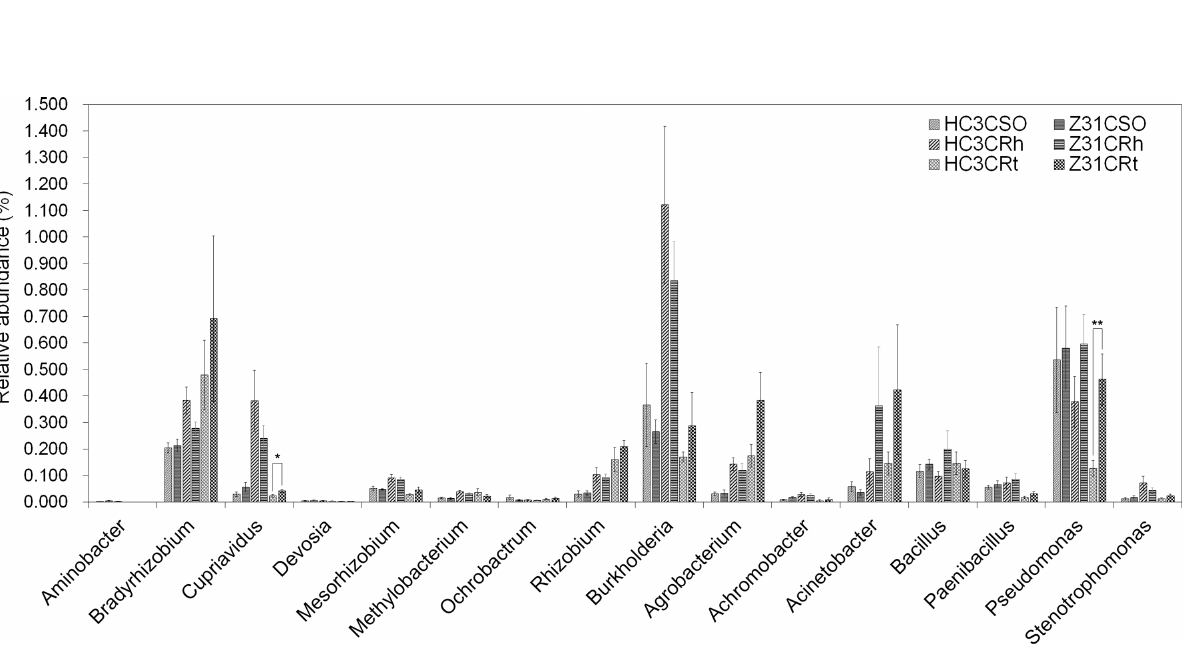
PLOS ONE | https://doi.org/10.1371/journal.pone.0192008 February 6, 2018 12 /